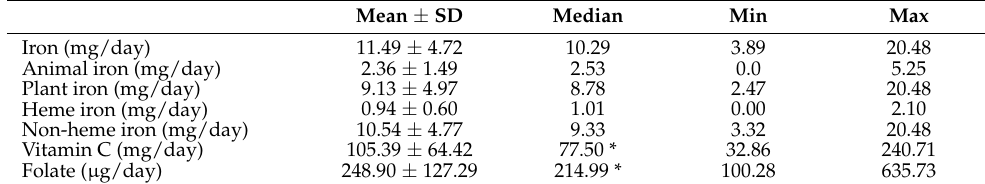
Table 2. Baseline dietary intake of the participants of the study ( n =